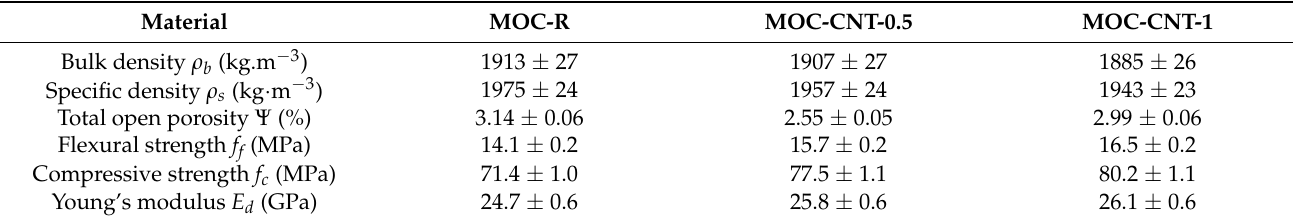
Table 2. Basic structural and mechanical properties of the tested